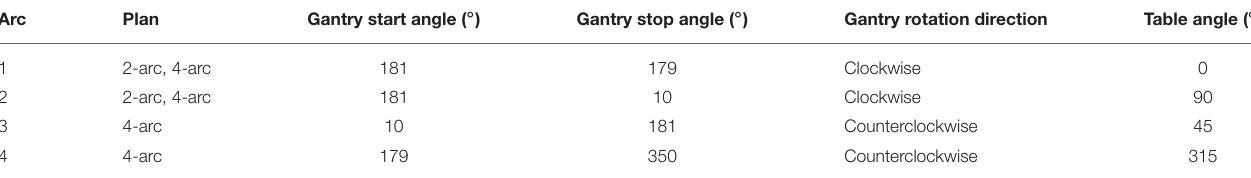
TABLE 1 | Arc geometry set by Yuan et al. (40) for SRS-VMAT (single-isocenter) plans on treatment of multiple brain metastases. Arc Plan Gantry start angle ( ◦ ) Gantry stop angle ( ◦ ) Gantry rotation